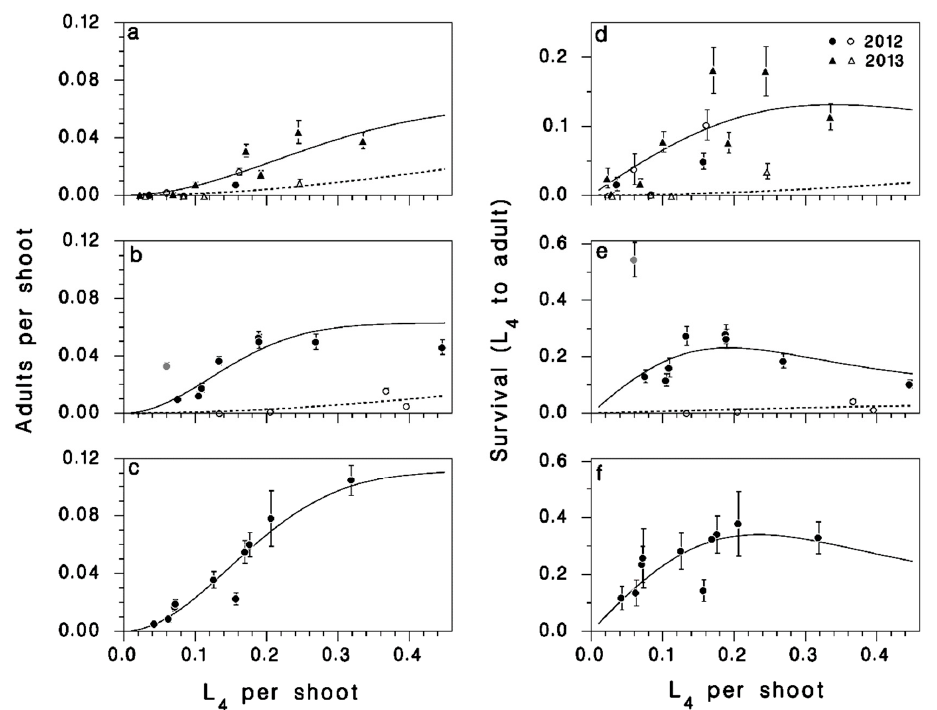
Figure 3. Left column: Relationship between larval and adult density in ( a ) 2012 (untreated and Bt-treated populations included) and 2013; ( b ) 2014; ( c ) 2014 among the SOPFIM plots (no insecticide treatments). Lines: Equation (1) (reduced, × N ). Right column: Relationship between larval density and survival to the adult stage ( d ) in 2012 and among 2013; ( e ) 2014; ( f ) SOPFIM plots in 2014. Lines: Equation (1) (reduced; solid: Untreated; dotted: Insecticide). Vertical bars: SEM. Open symbol in ( b ) and ( e ): Outlier from plot LSL-24 in 2014 not used in model fitting.